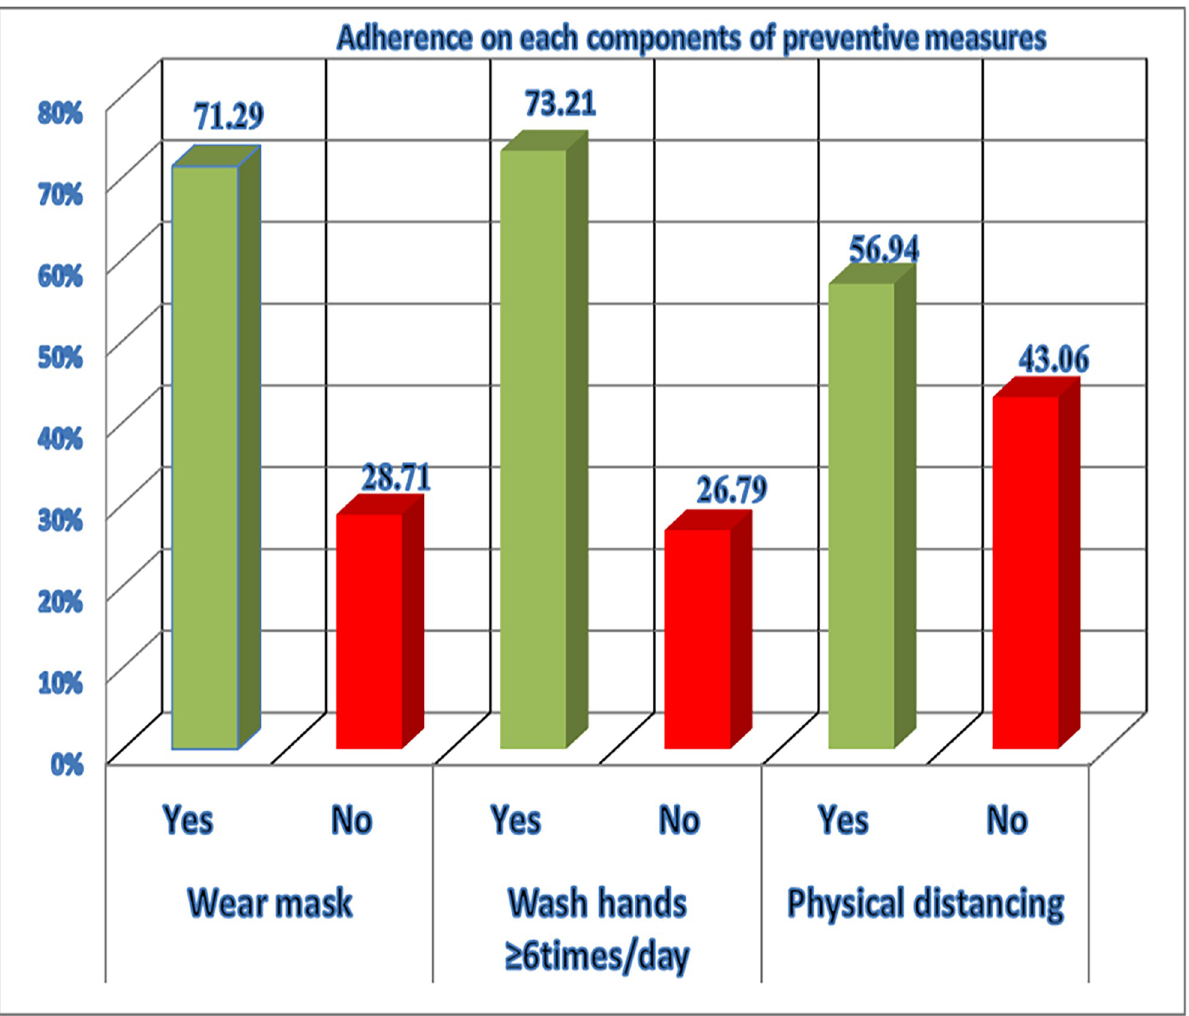
Fig 2. Distribution of adherence of COVID-19 mitigation measures among health care workers in referral hospitals of Amhara regional state of Ethiopia.